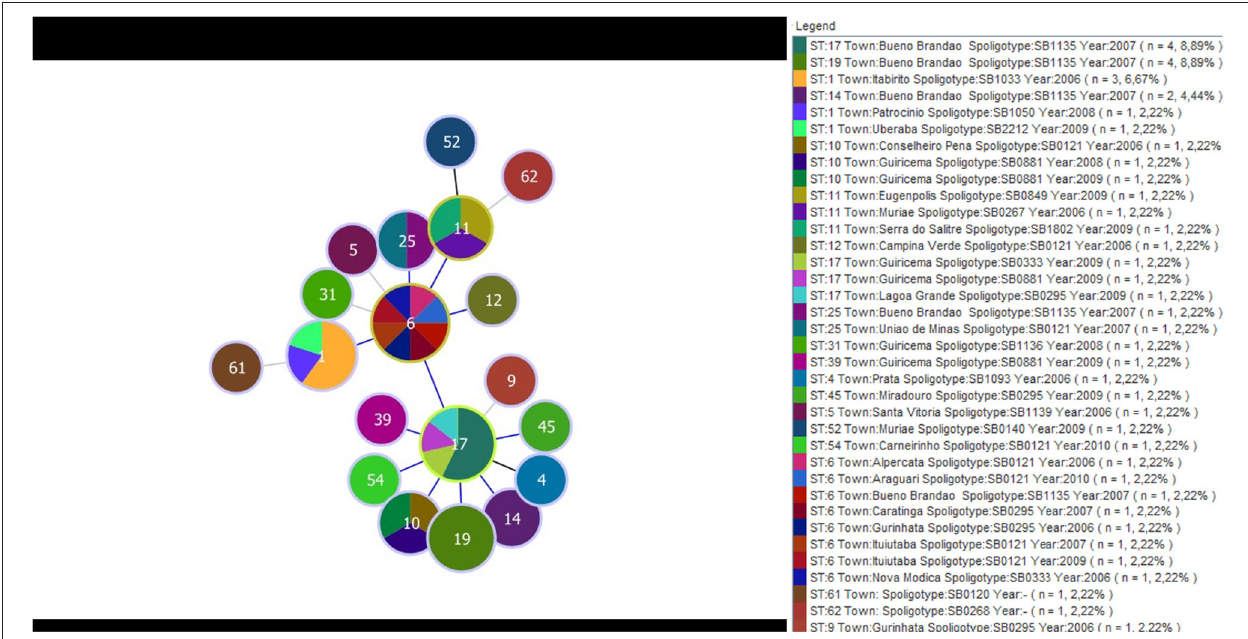
FIGURE 3 | Minimum spanning tree displaying the distribution of 19 type sequences and 17 spoligotypes determined by the MST and Spoligotyping, respectively. The data were obtained from 43 isolates of M. bovis from 22 municipalities in MG and isolates between the years 2006 and 2010. The colors represent the different spolitypes and ‘ n ’ indicates the number of isolates with the same genotype profile.